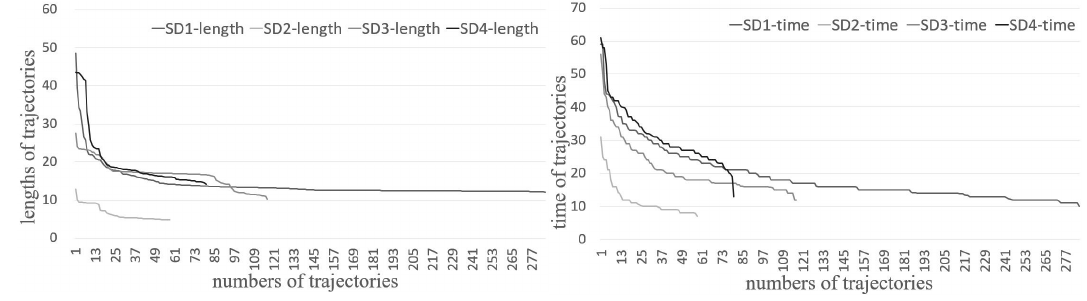
Figure 7. Lengths and time distribution of the SD1–SD4 data.